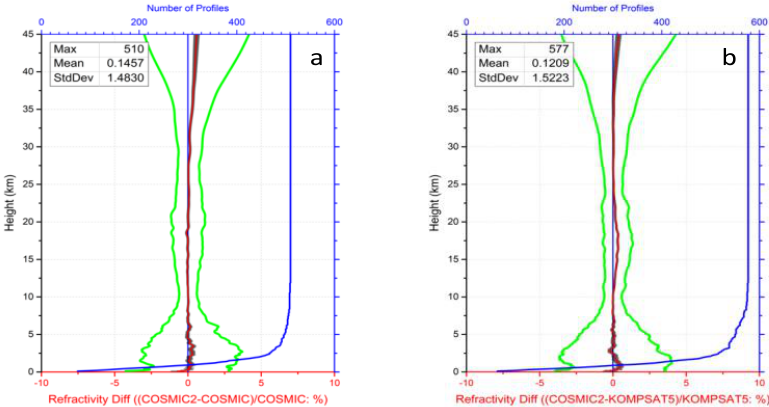
Figure 6. The fractional refractivity comparisons for ( a ) COSMIC-2 – COSMIC pairs for October 2019 and ( b ) COSMIC-2 – KOMPSAT-5 pairs. The mean differences are in the red line, and the standard deviations of the mean difference are in the green line. The sample numbers are in the blue line. The SEM is in the horizontal black lines superimposed on the mean.